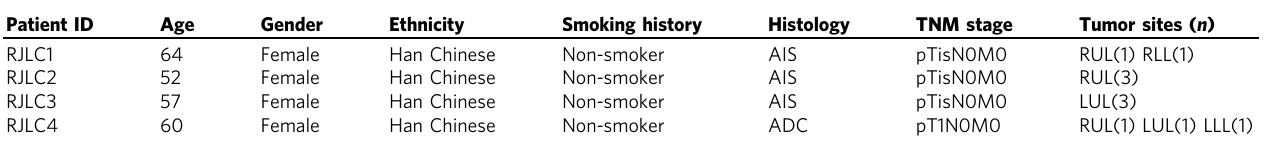
Table 1 Patient characteristics in the MSLC cohort Patient